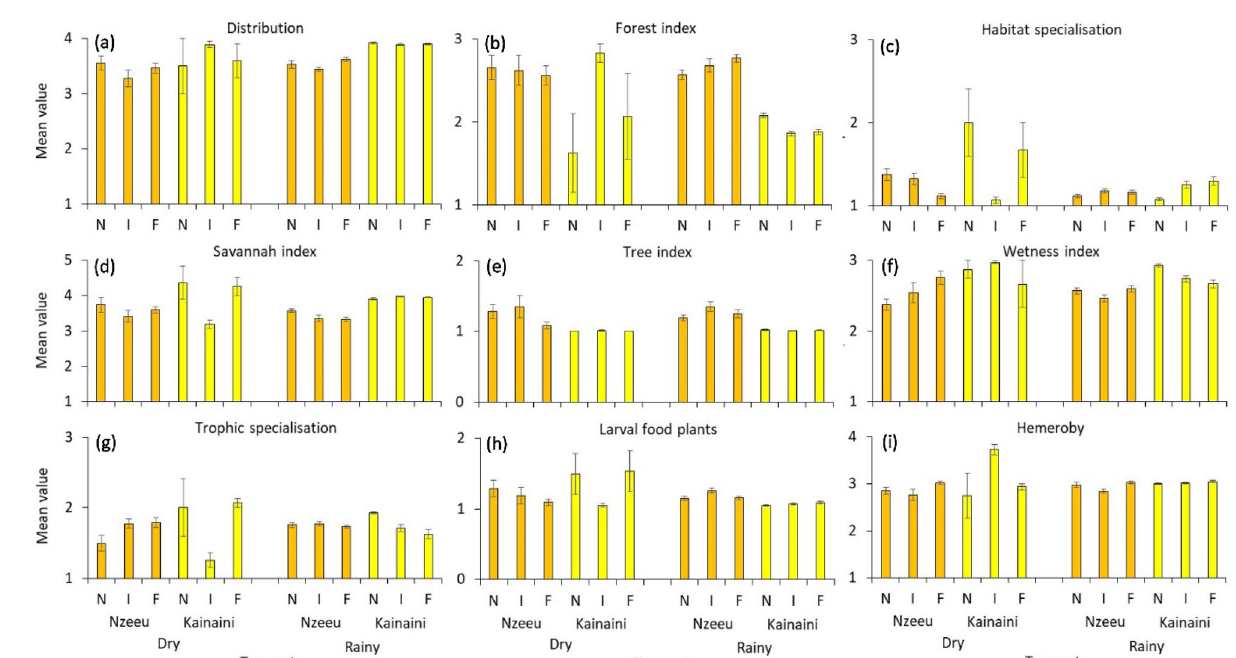
Figure 3. Average abundance-based butterfly ecological traits in transects along the Nzeeu (orange) and Kainaini (yellow) rivers near Kitui city in southern Kenia. Error bars denote standard errors. Traits used are ( a ) geographic distribution (4 categories), ( b ) forest index (5 categories), ( c ) habitat specialisation (3 categories), ( d ) savannah index (5 categories), ( e ) tree index (3 categories), ( f ) wetness index (3 categories), ( g ) larval foodplant specialisation (3 categories), ( h ) larval food plant type (dicotyledonous, monocotyledonous), and ( i ) hemeroby index (4 categories). Categories (apart from larval food plant type) are always in increasing order. Abbreviations: N—near river transects; I—transects at intermediate distance from river (i.e. 250 m); F—transects far from river (i.e. 500